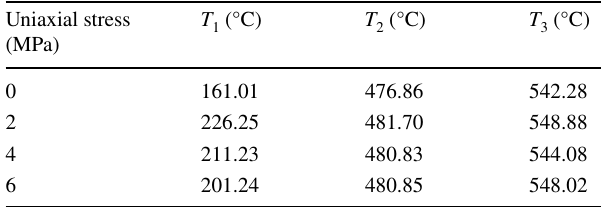
Table 2 Each characteristic temperature under different uniaxial stress Uniaxial stress (MPa)